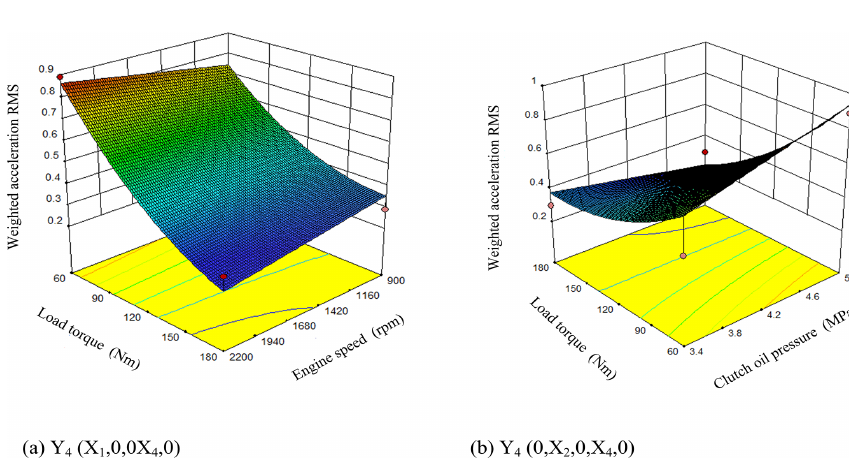
Figure 11. Influence of interaction effect on speed drop.